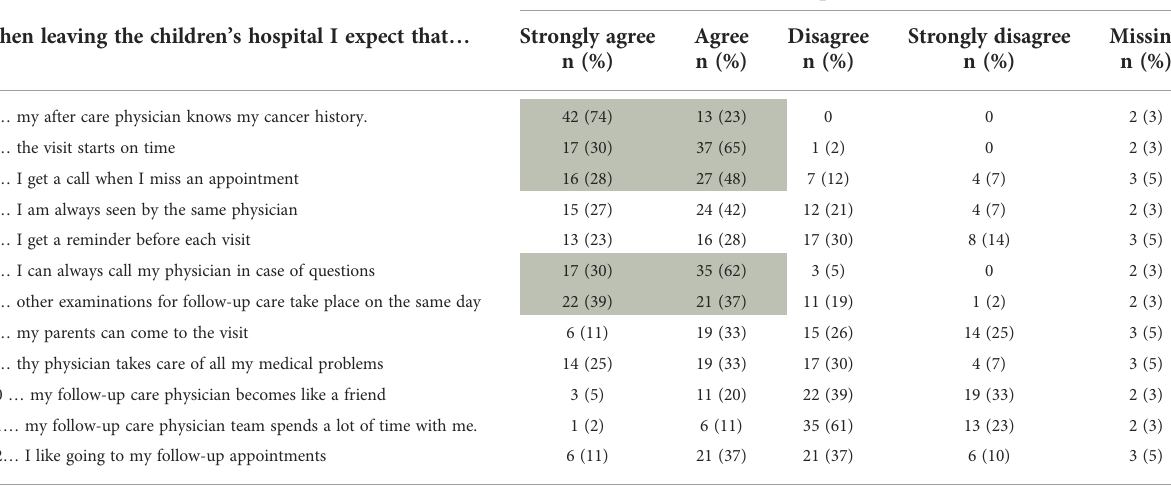
TABLE 3 Results from the Expectation Scale, shaded areas indicating at least 75% agreement with the respective statement (n=57).